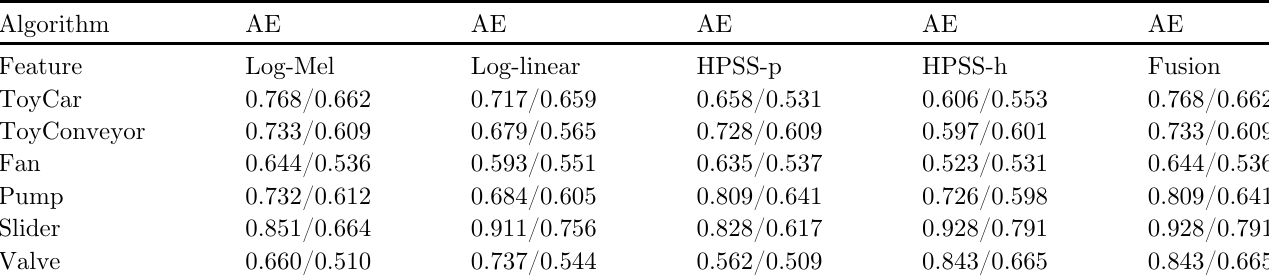
Table 4. Using the same convolutional neural network and different feature extraction methods, AUC/pAUC value